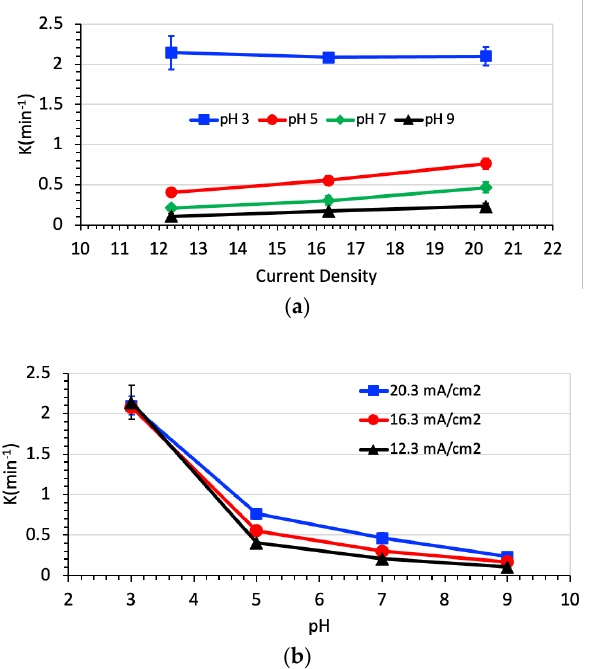
Figure 3. Electrochemical oxidation rate constants of naproxen in surface water. ( a ) effect of current density and ( b ) effect of pH. Average of three replicates.